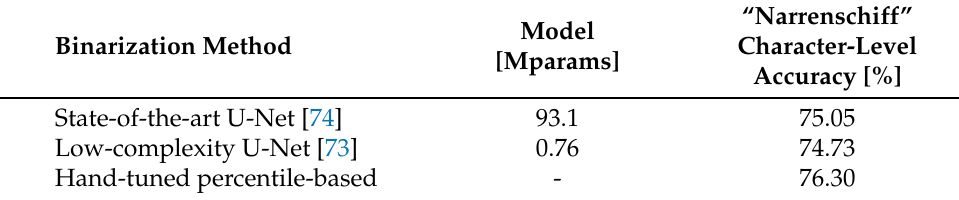
Table 1. Character-level accuracy for binarization using U-Net based and PBB